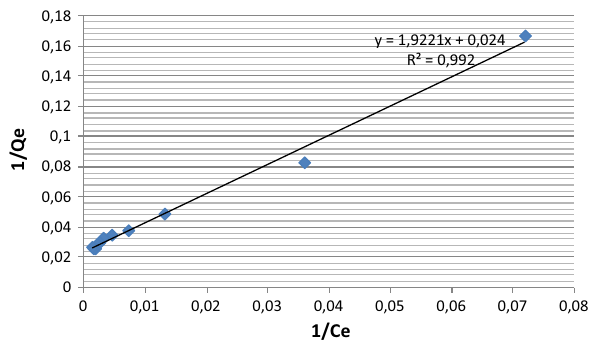
Fig. 2 Langmuir adsorption isotherm